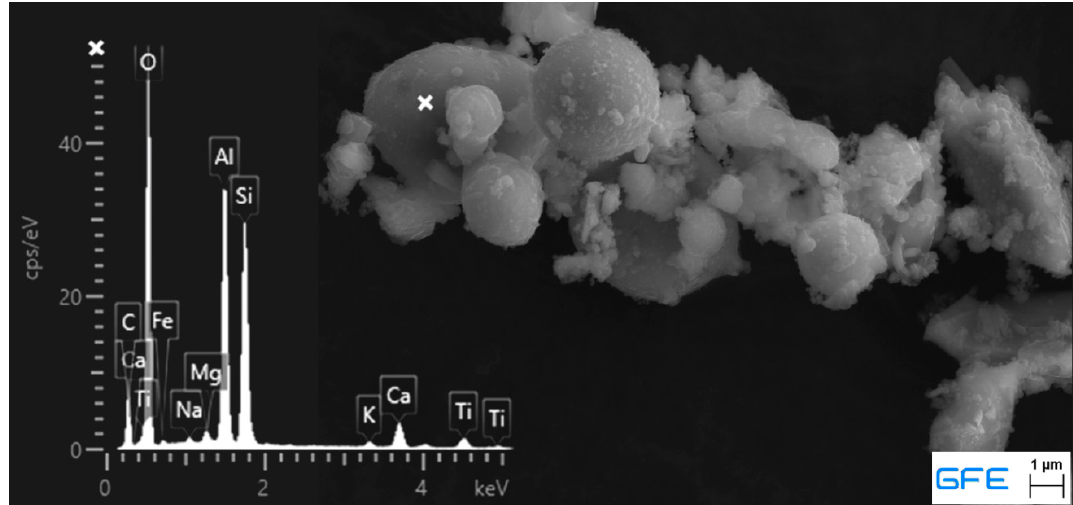
Figure 2. Scan electron microscopy ( SEM) picture and corresponding energy dispersive X-Ray (EDX) spectrum of ready dry mix <125 µm, fly ash.